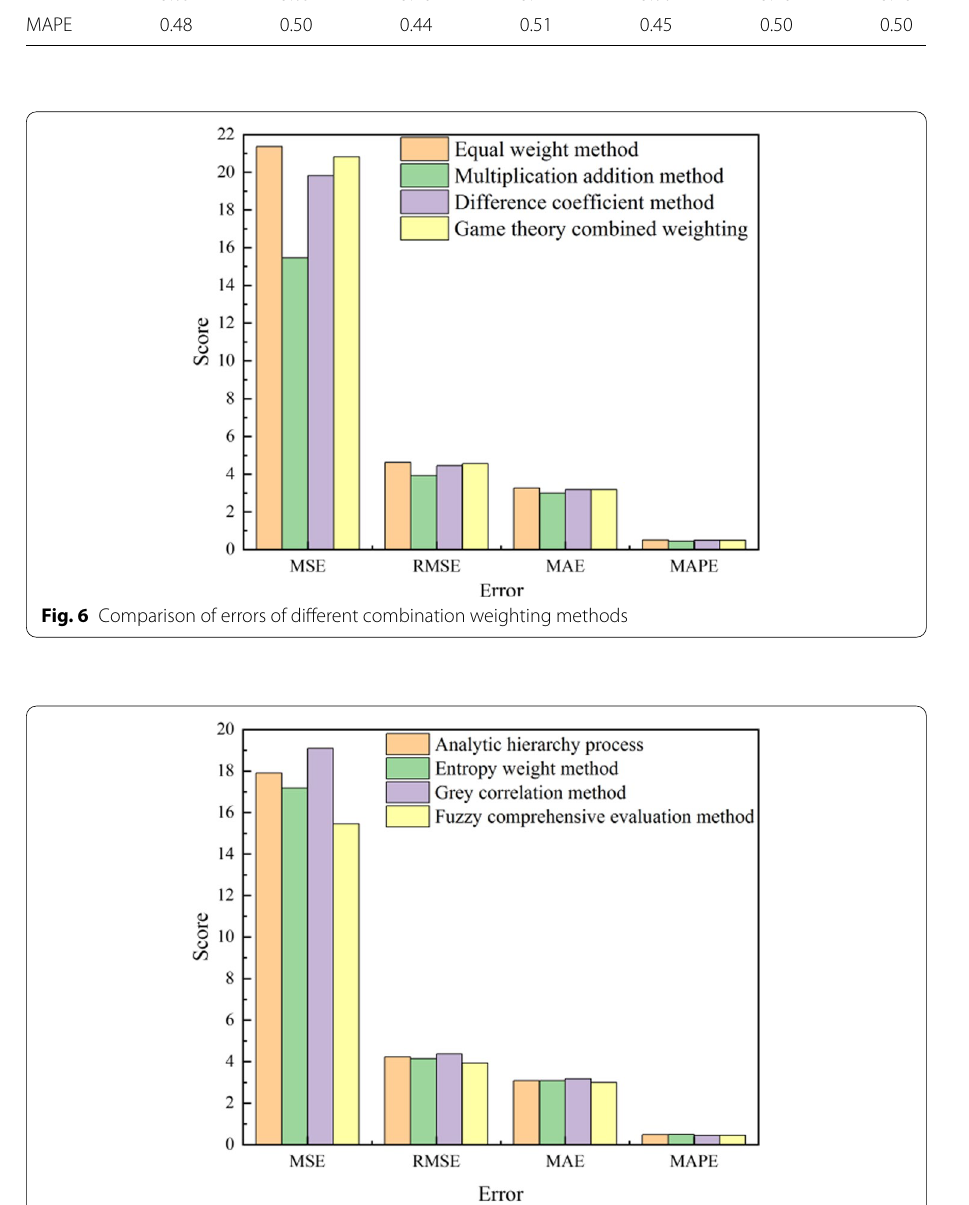
Fig. 7 Error comparison of different evaluation